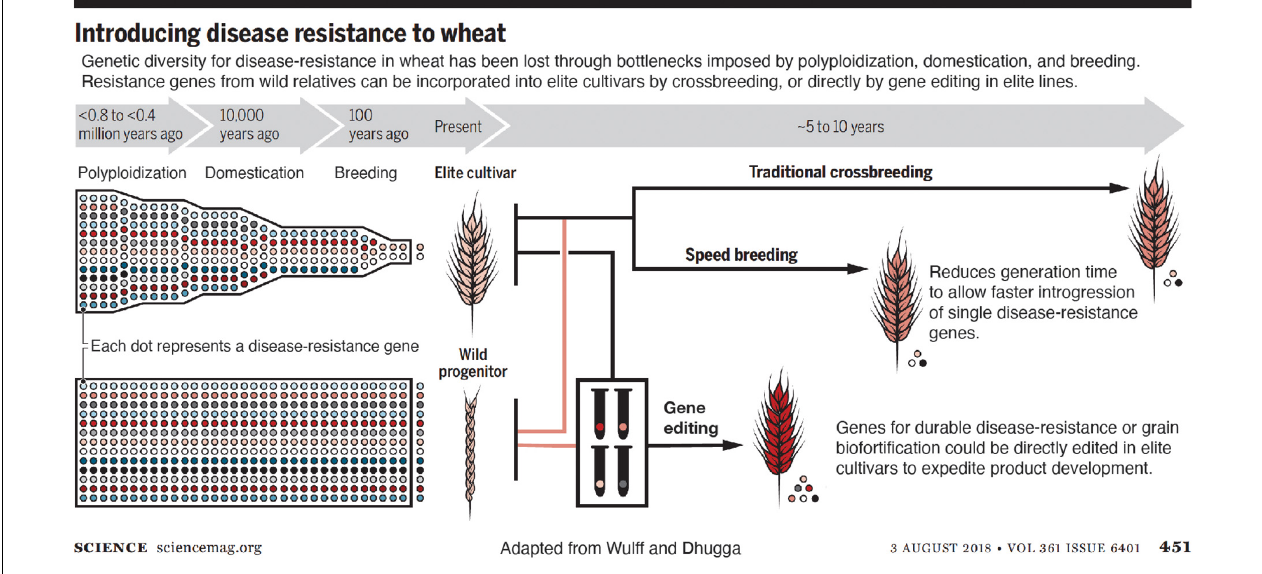
FIGURE 1 | Introducing disease resistance into wheat. Genetic diversity for disease resistance in wheat has been lost through bottlenecks imposed by polyploidization, domestication, and breeding. Resistance genes from wild relatives can be incorporated into elite cultivars by crossbreeding, which is sped up by speed breeding, and further accelerated by gene editing directly in elite lines (from Wulff and Dhugga, 2018). Reprinted with permission from